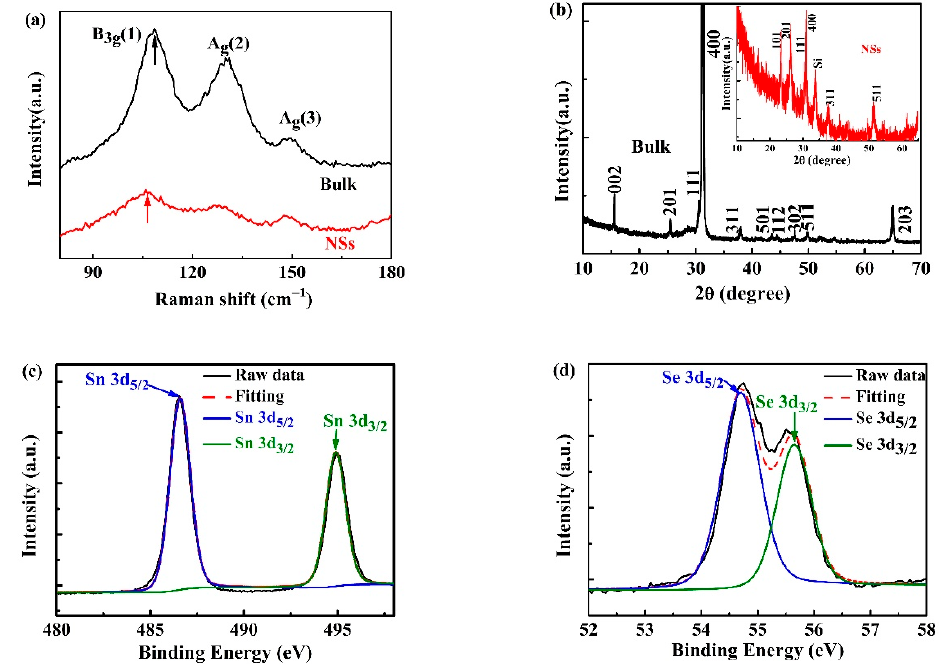
Figure 3. ( a ) Raman spectra and ( b ) XRD patterns of the bulk SnSe and SnSe NSs. High-resolution ( c ) Sn 3d and ( d ) Se 3d region XPS spectra of SnSe NSs .